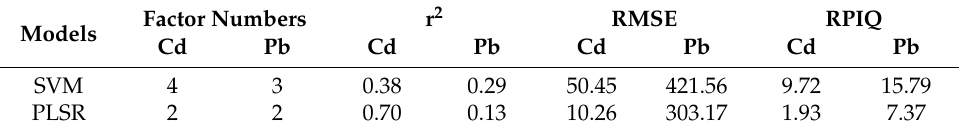
Table 6. Evaluated parameters of support vector machine (SVM) prediction and partial least squares regression (PLSR) predication.